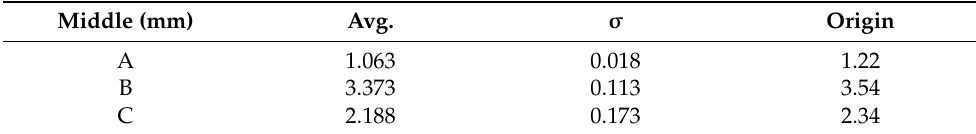
Table 6. Hole dimensions measured by the SEM form specimens 1 to 6.